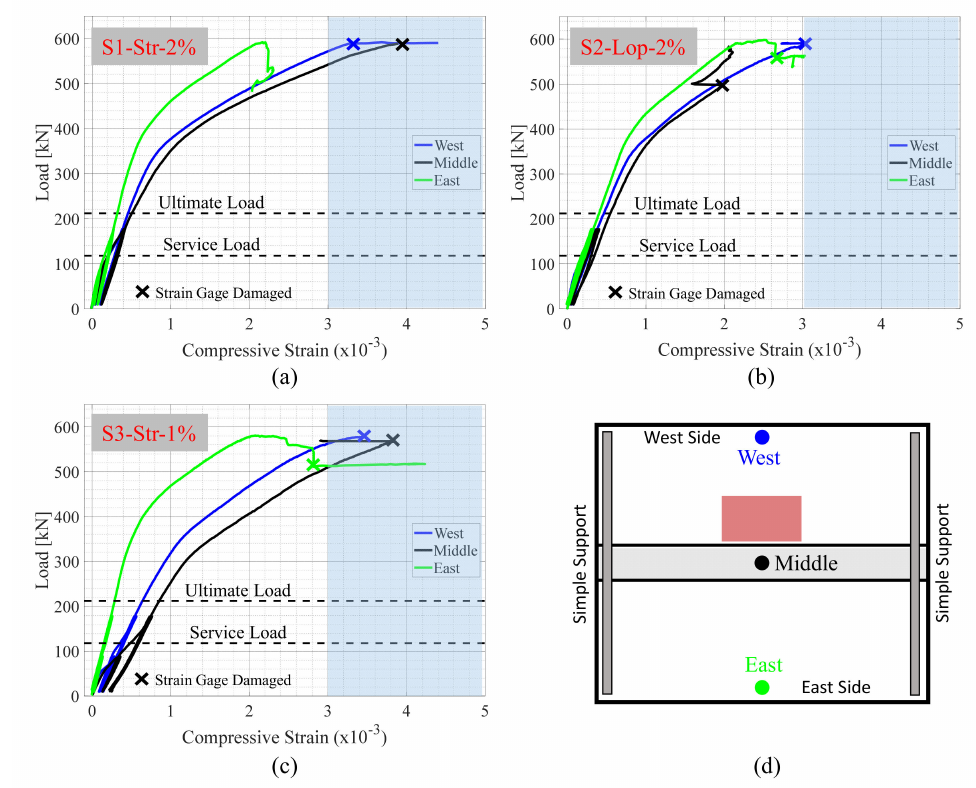
Figure 11. Load versus concrete compressive strain measured at mid-span of specimens ( a ) S1-Str-2%; ( b ) S2-Lop-2%; and ( c ) S3-Str-1%.; ( d ) sketch of the test specimens with the locations of the concrete strain